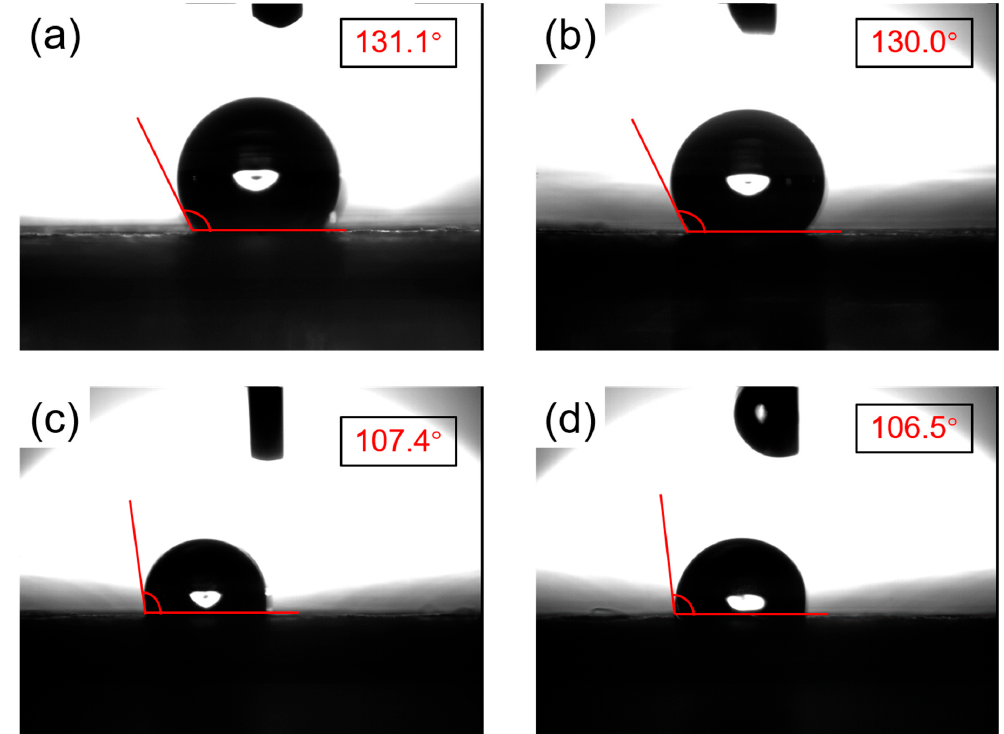
Figure 6. The optical image of WCA. ( a , b ) Contact angle of the PTFE nanofiber membrane is 131.1° and 130.0°; ( c , d ) contact angle of the PTFE microfiber membrane substrate is 107.4° and 106.5°.